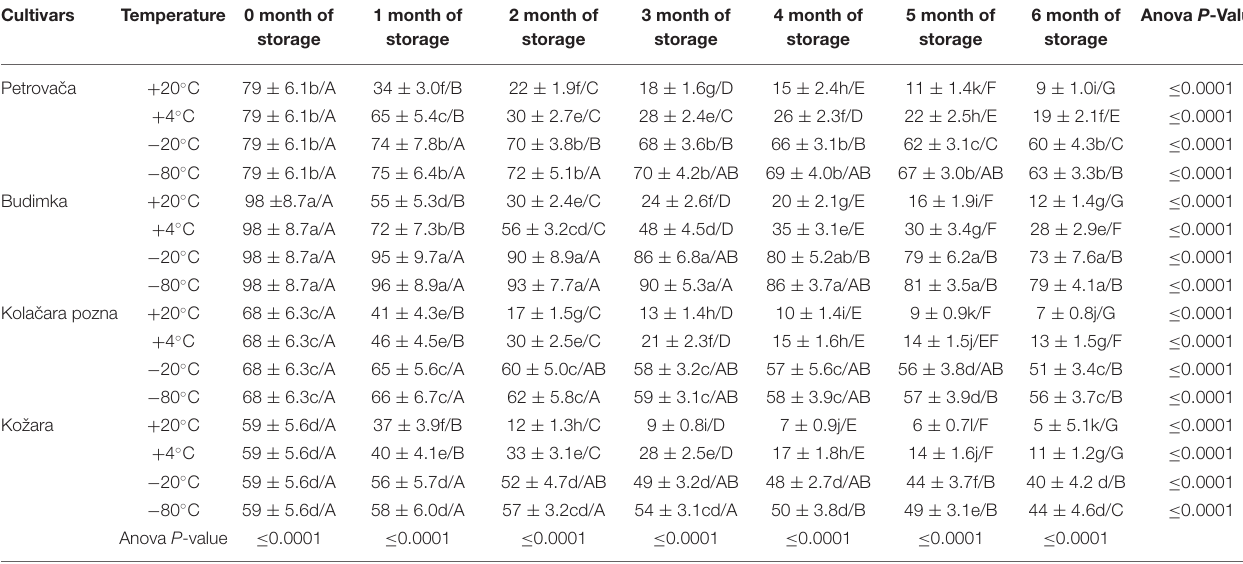
TABLE 2 | Effect of different storage temperatures and duration on in vitro pollen viability of four autochthon apple cultivars.